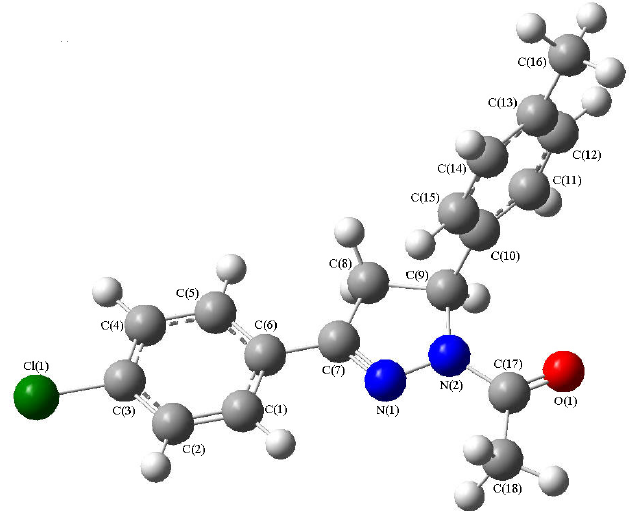
Figure 2 . One optimized molecular structure for the title